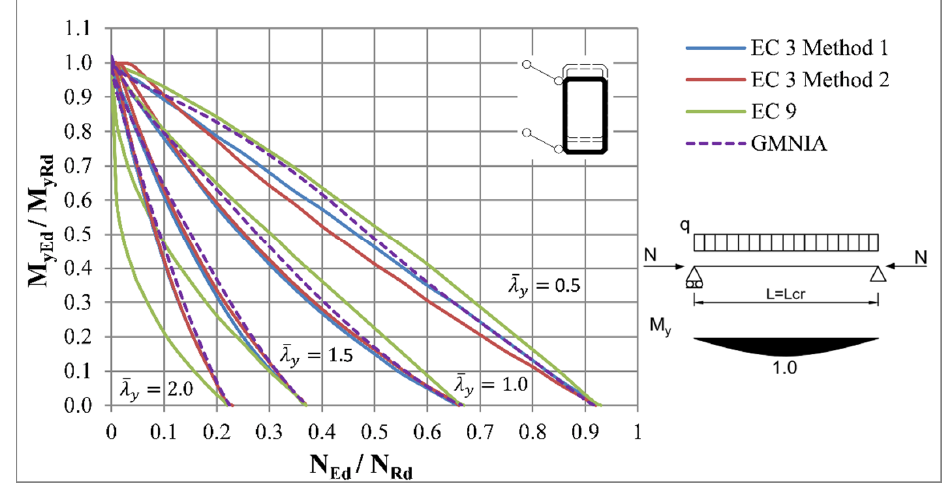
Figure 35. Interaction curves for laterally restrained beam-columns with RHS cross-section.